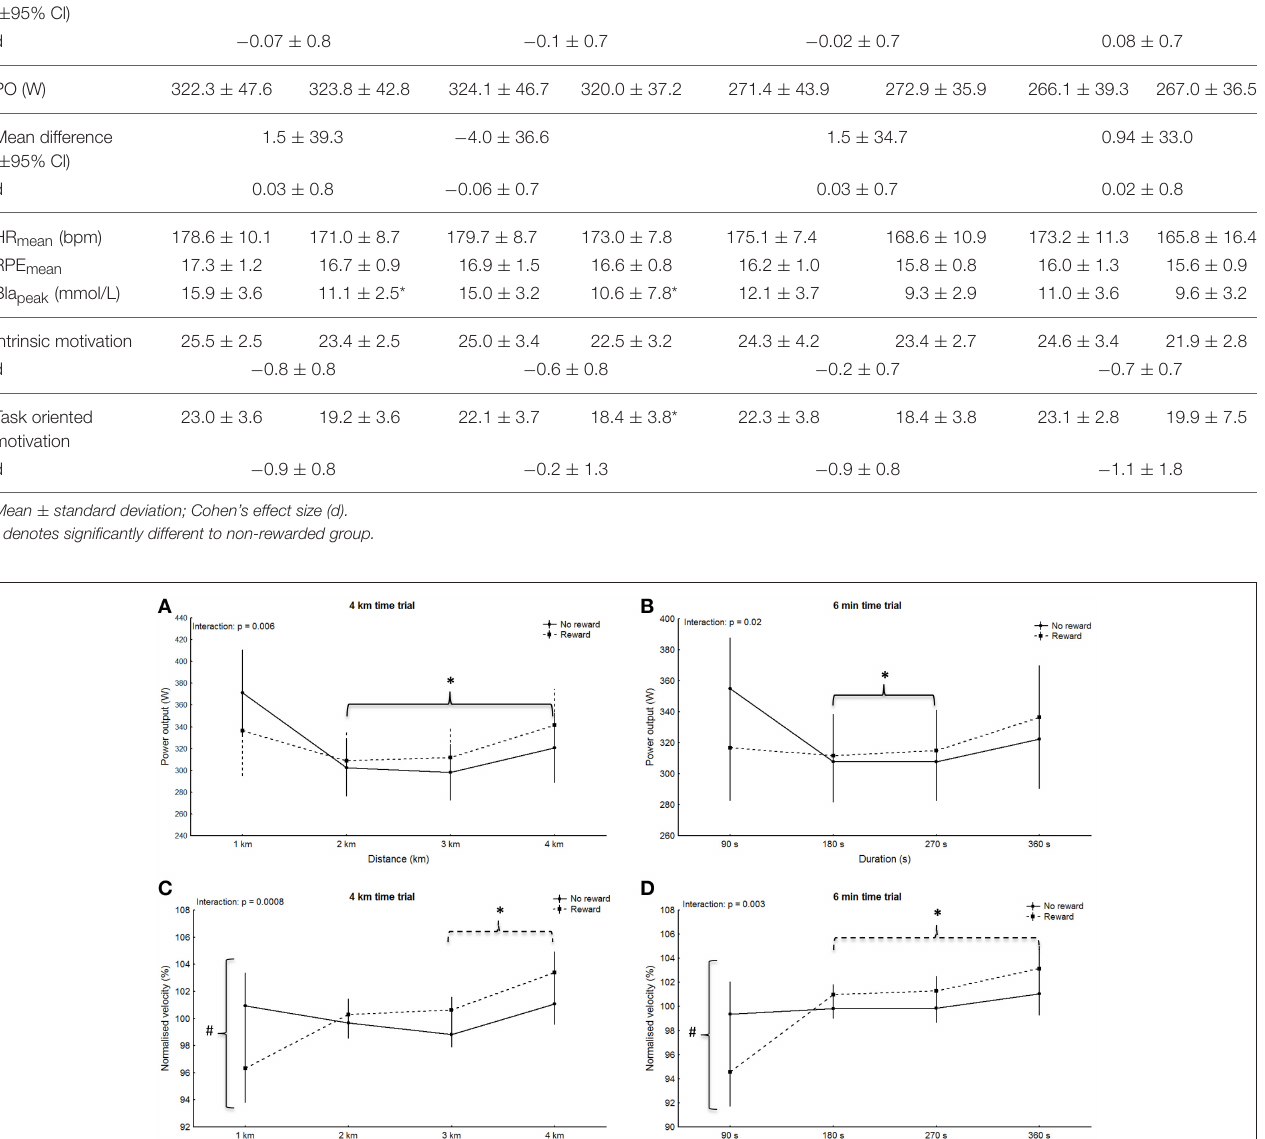
FIGURE 1 | Pattern of power output (A,B) with corresponding normalized pacing (C,D) during the 4 km (A,C) and the 6min (B,D) time trials. Means ± standard deviation. Solid line, non-rewarded; dotted line, rewarded. * indicates a significant within-trial difference to split one; ∧ indicates a significant within-trial difference to the last split; # indicates a significant effect between groups at this split.